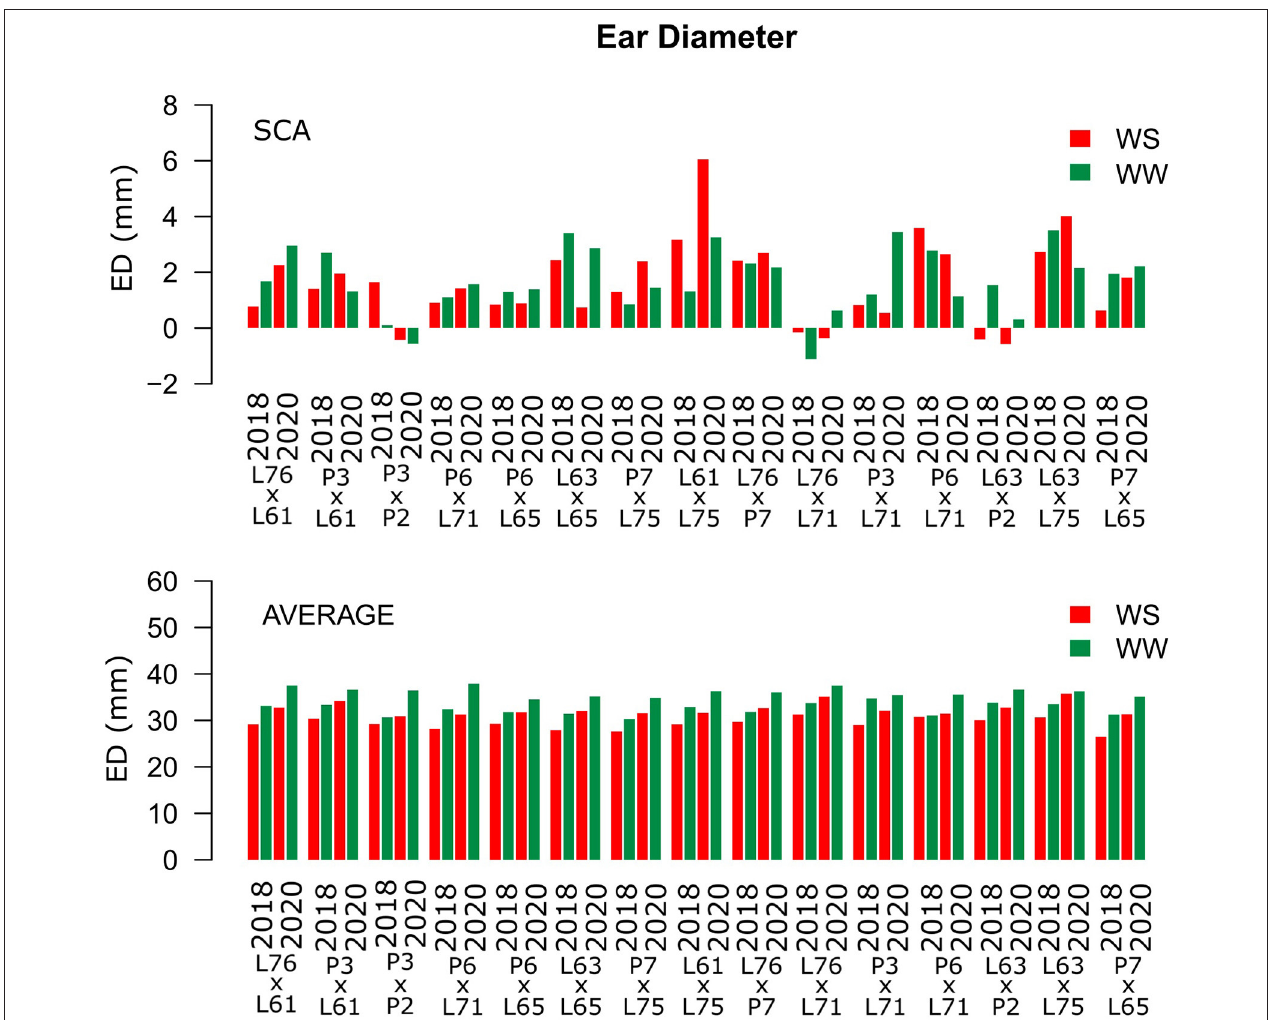
FIGURE 7 | Estimation of the SCA and ED (mm) mean values for popcorn hybrids evaluated under two WCs and crop seasons in 2018 and 2020. WS is represented by red bars and the WW condition is represented by dark-green bars.